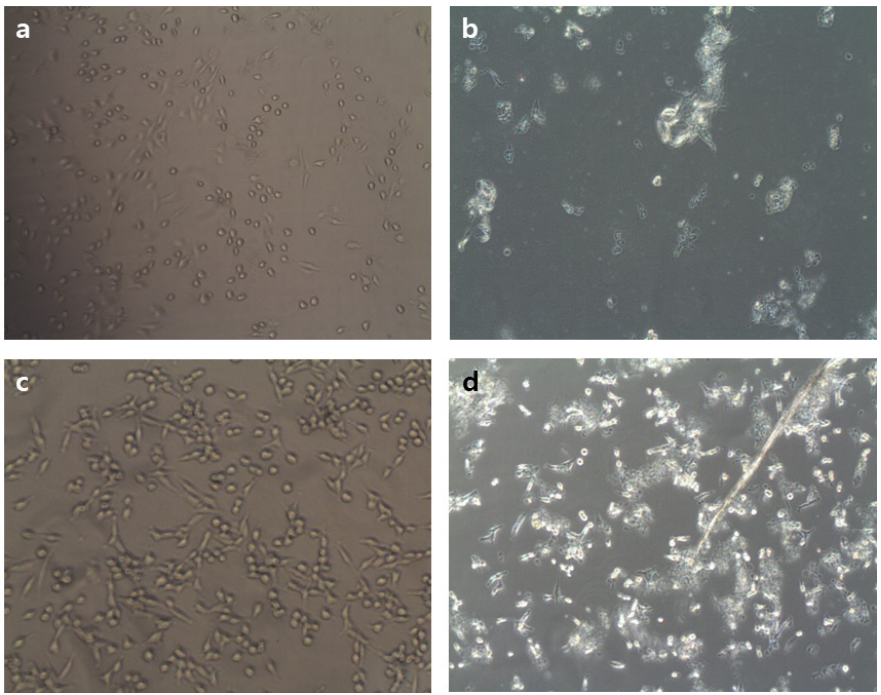
Figure 7. Cytotoxicity test of human breast (MCF-7) and intestinal (Caco-2) cancer cell lines by treatment of mixture of five surfactin isoforms of cheonggukjang (MSIC): ( a ) MCF-7 cells (control); ( b ) MSIC-treated MCF-7 cells (100 μ g/ μ L); ( c ) Caco-2 cells (control); and ( d ) MSIC-treated Caco-2 cells (100 μ g/ μ L).